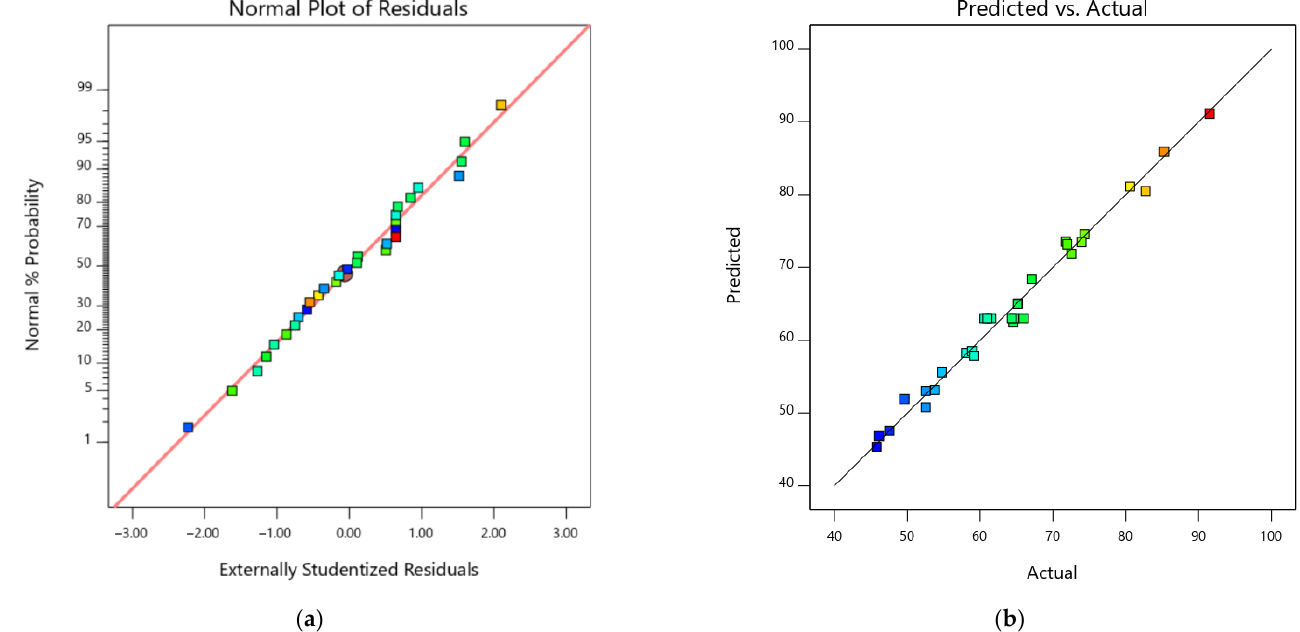
Figure 3. Tensile strength: ( a ) normal plot of residuals; ( b ) predicted vs. actual plot.